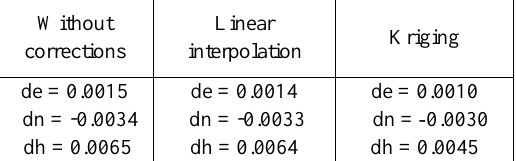
Table 4. Master-Rover baseline processing accuracy after relocating master reference